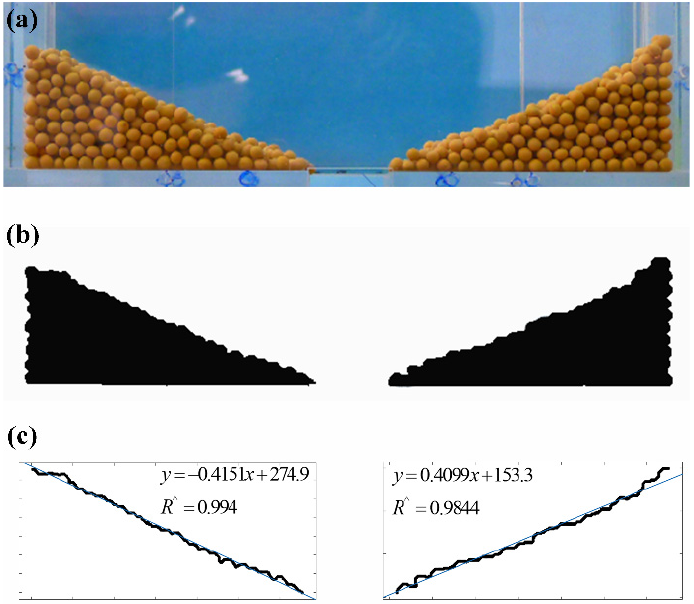
Figure 10. ( a ) Photo of the piling angles, ( b ) binarization image of the piling angles, and ( c ) the fitting line of the outline of the binarization image.